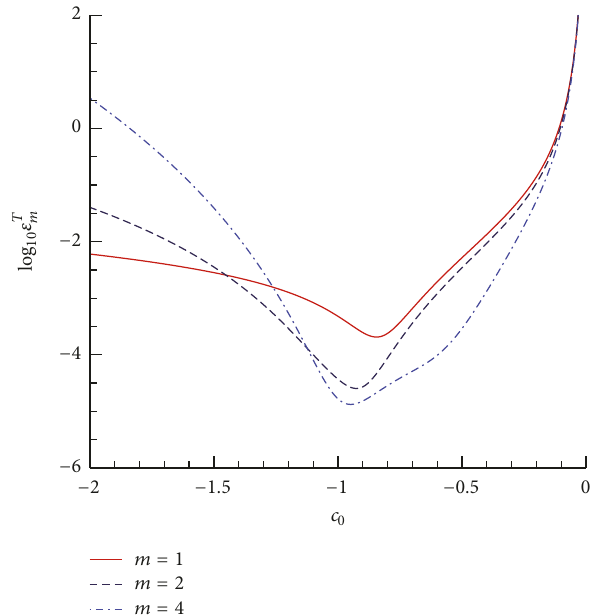
Figure 2: Residual squares of log 10 𝜀 𝑇 𝑚 of the 𝑚 th-order homotopy approximation 𝑐 0 . Solid line, 𝑚 = 1 ; long dashed line, 𝑚 = 2 ; dash- dotted line, 𝑚 = 4 .